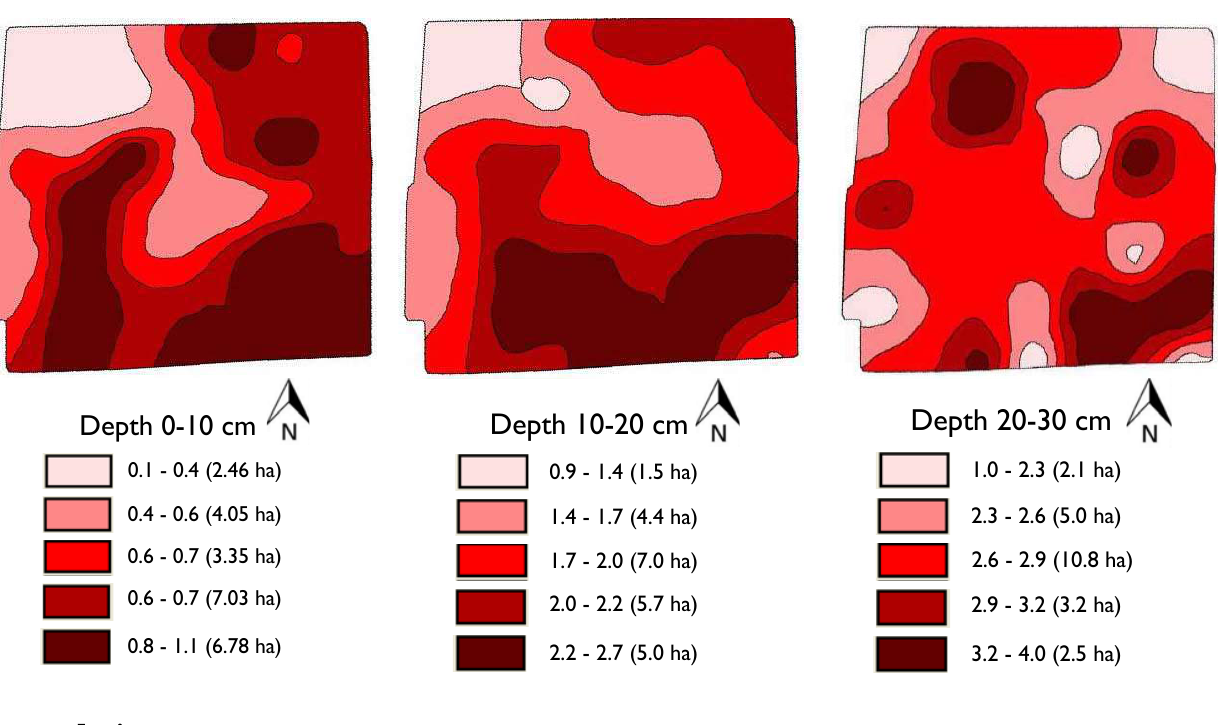
Figure 6. Contour maps of soil resistance (MPa) at different soil depths using SSPS